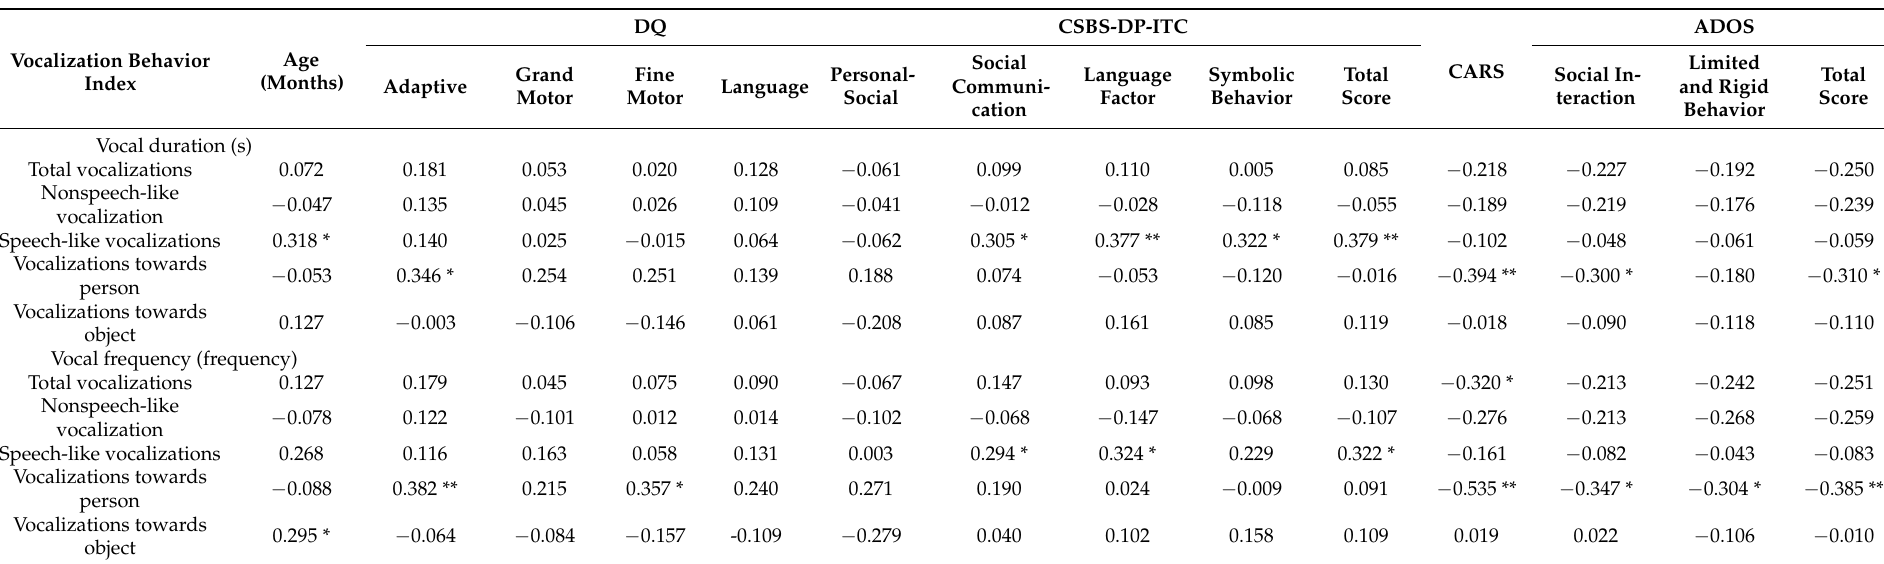
Table 3. Correlation analysis of SFP vocalizations in the ASD group with age, development level and clinical symptoms ( r